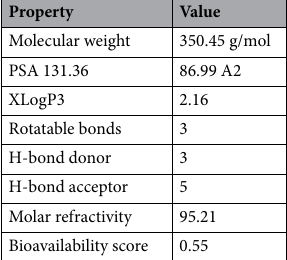
Table 1. Molecular properties of andrographolide.